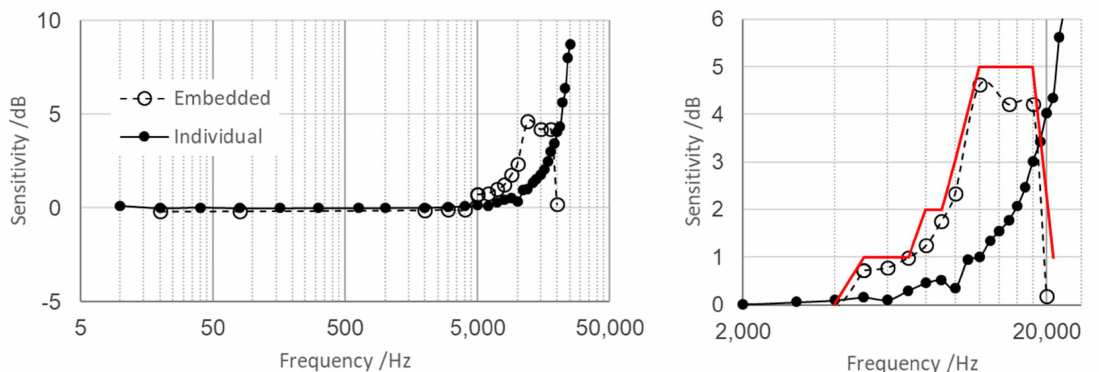
Figure 8. Full scale range ( left plot) and high-frequency range detail with related calibration uncer- tainties ( right plots) of the comparison between the sensitivity of the individual sensing element and the sensitivity of the embedded sensor along the vertical